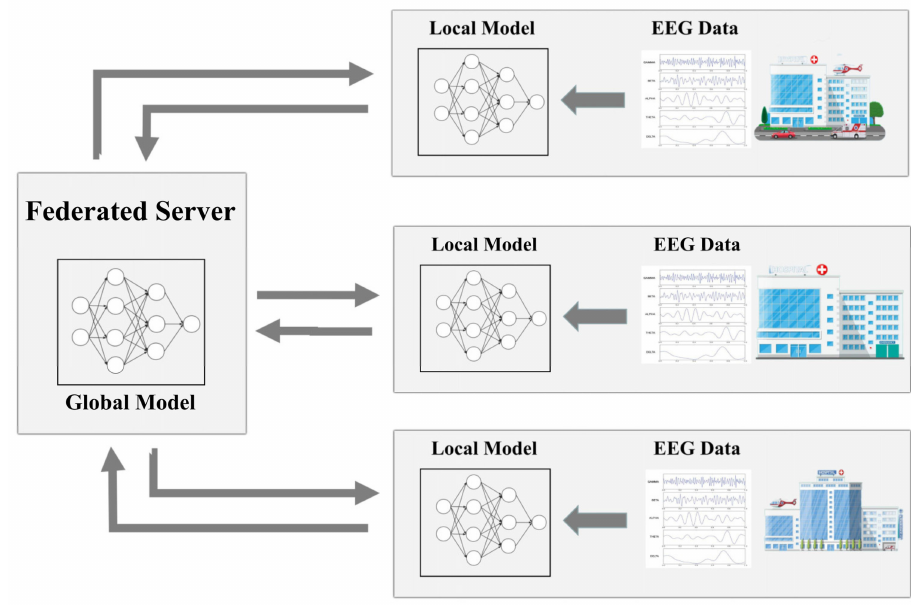
Figure 1. Federated learning framework for training emotion recognition